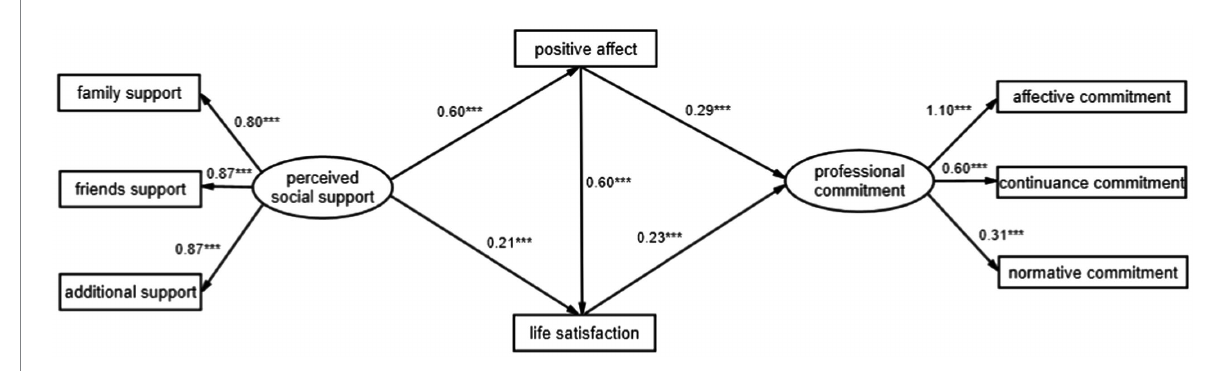
FIGURE 2 The path relationship between perceived social support, positive affect, and life satisfaction on professional commitment.